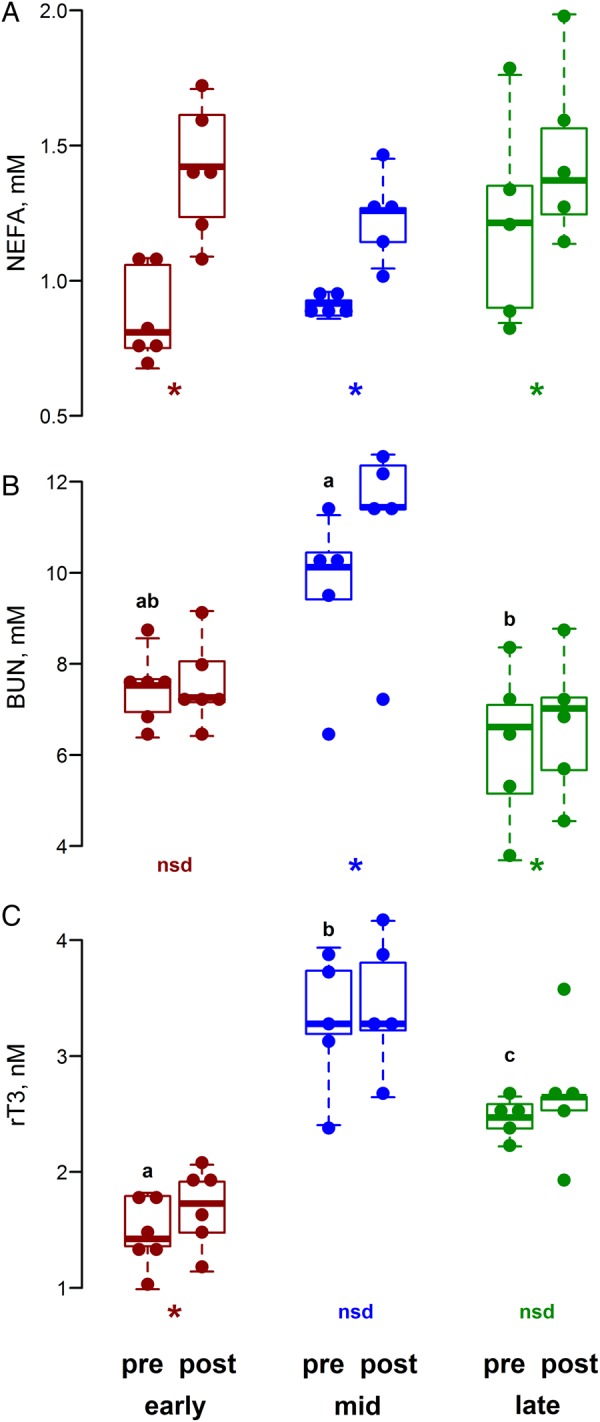
Circulating concentrations of non-esterified fatty acids (NEFA; A), blood urea nitrogen (BUN; B) and reverse triiodothyronine (rT3; C) before and 2.5 h after the administration of exogenous ACTH (pre and post, respectively) at the beginning, middle and end of the moulting period (early, mid and late, respectively). Coloured asterisks along the x-axis indicate a significant difference between the pre and post samples (Student's paired t test, P < 0.05); ‘nsd’ indicates no significant difference detected. Letters above the pre groups indicate differences in the initial concentrations among moulting stages (early, mid and late; ANOVA followed by Tukey's HSD test, P < 0.05).